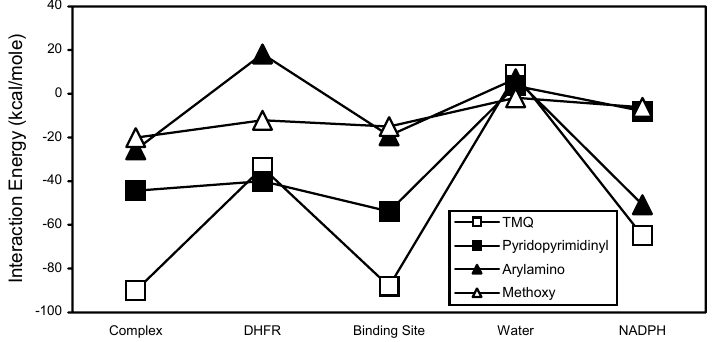
Figure 8. Comparison of interaction energy analysis TMQ and its substructural